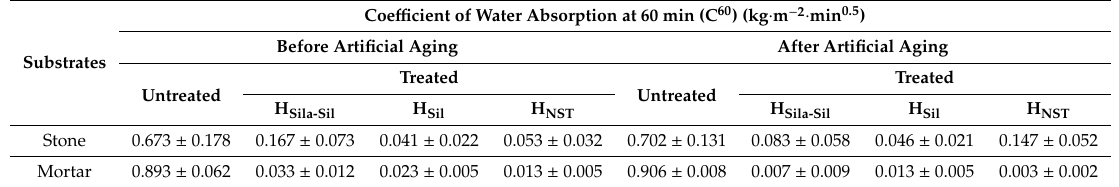
Table 5. Average results and relative standard deviation of the water absorption coe ffi cient under pressure (C 60 ) of treated and untreated specimens, before and after artificial aging